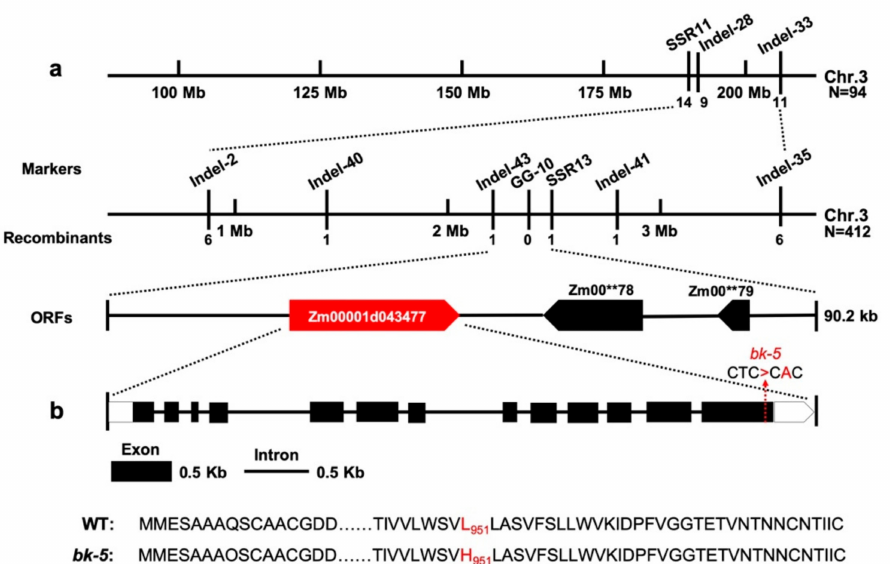
Figure 4. Map-based cloning and identification the gene of bk-5 using B73 × bk-5 F2 segregation populations. ( a ) Map-based cloning of bk-5. bk-5 was preliminary mapped between the flanking markers SSR11 and Indel-33 on chromosome 3 using B73 × bk-5 F2 segregation populations, with an estimated length of 16.3 Mb (n = 94 individuals with zebra leaf phenotype). bk-5 was final mapped between molecular markers Indel-33 and SSR13, with an estimated length of 90.2-Kb (n = 412 individuals with brittle stalk phenotype). The target region contained three ORFs based on the genome sequence. ( b ) The gene structure and identification of the mutant gene by sequencing. There was a mutation from T to A on the last exon of gene Zm00001d043477 (T001). The mutation caused the 951th amino acid mutation of Leu (L) to His (H). ORFs, open reading frames. N,